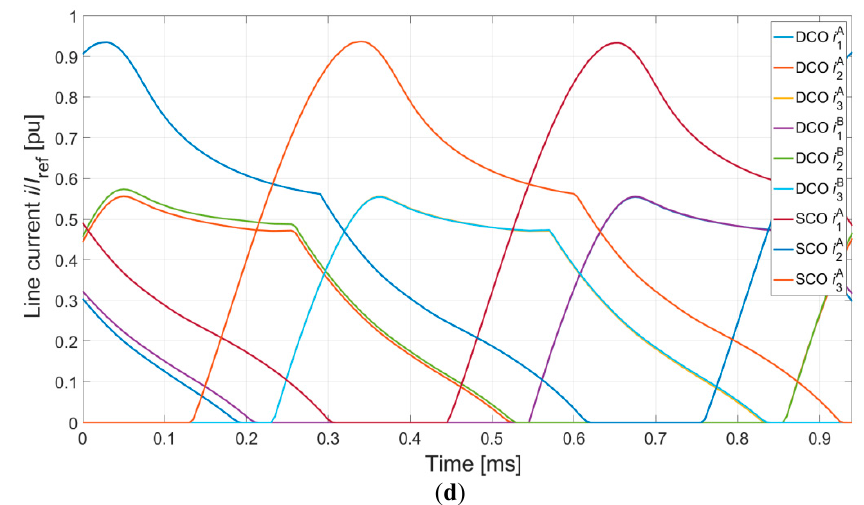
Figure 7 . Relative electromagnetic torque and line currents in DCO and SCO modes of the DCBLDCM and the DCSRM at high speed. (a) Electromagnetic torque T e for the DCBLDCM. (b) Line currents for the DCBLDCM. (c) Electromagnetic torque T e for the DCSRM. (d) Line currents for the